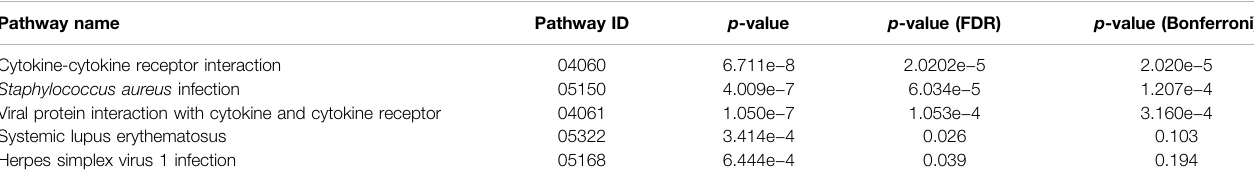
TABLE 1 | Top identi fi ed pathways and their associated p -values are given in the